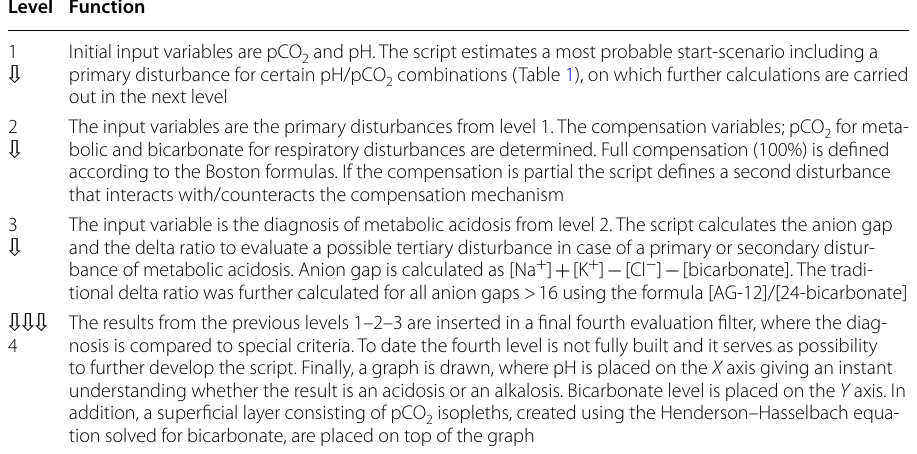
Table 2 Description of the structure of the algorithm Level